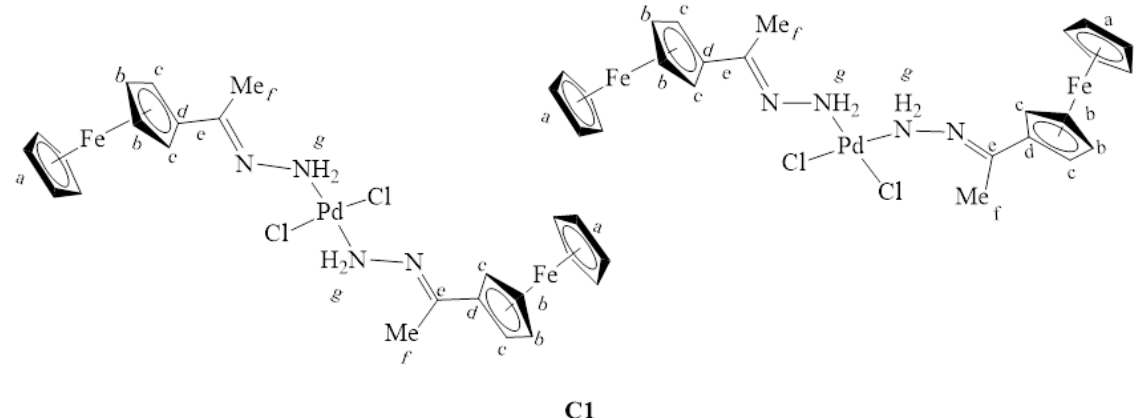
Figure 27. The chemical structures of C1 isomers.